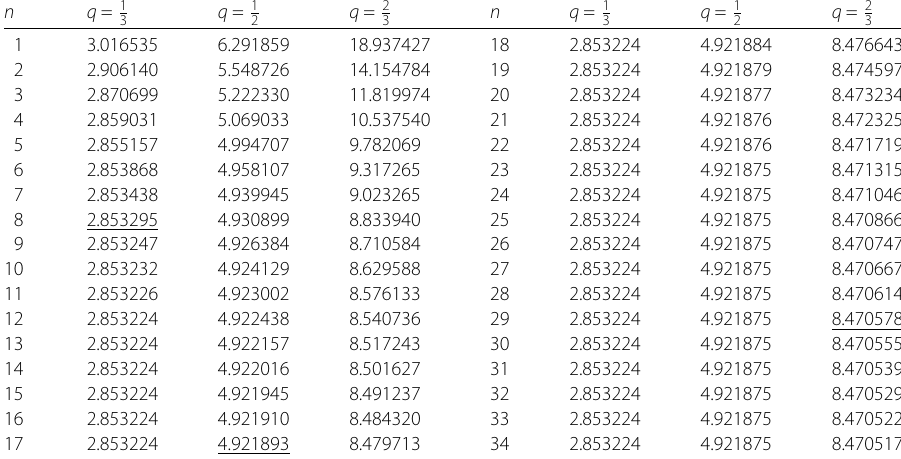
, 1 , 2 , x = 5 and n = 1,2, ... ,35 3 2 3